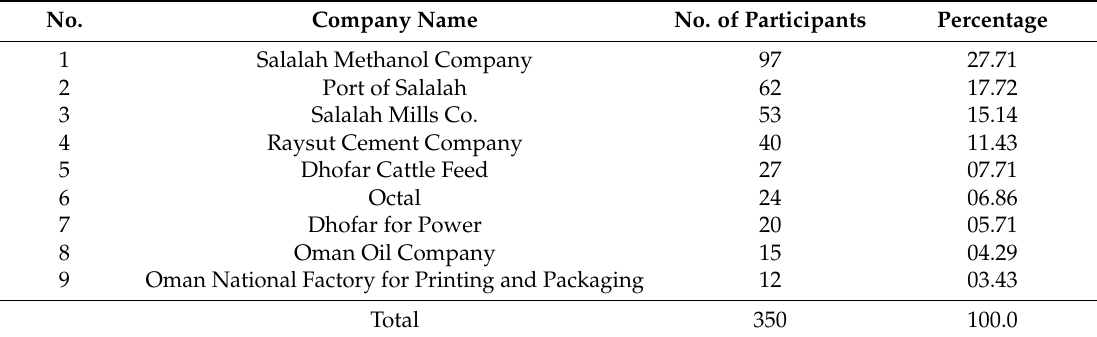
Table 1. Organizations in the